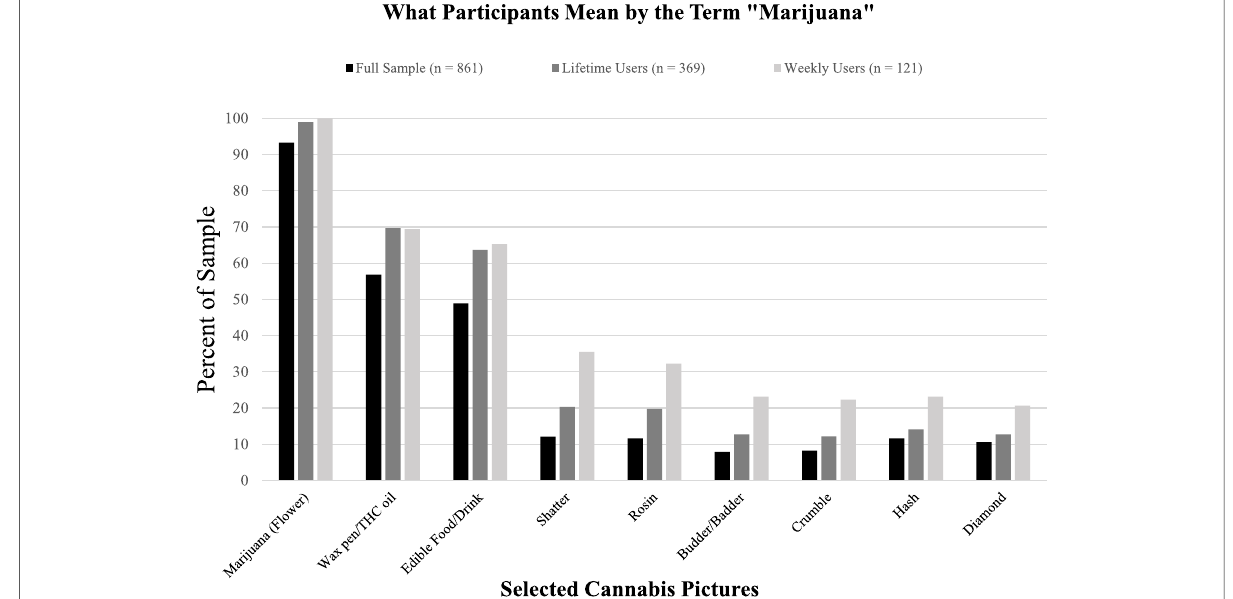
Fig. 1 Percentage of participants ( N 861 college students) who selected each cannabis product picture as part of their definition of “marijuana”. = Note: participants were asked to select picture(s) of cannabis products that they include in their definition of “marijuana.” This figure shows the percentage of the sample who selected each